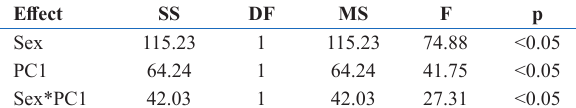
Table 1. Aegla marginata . ANCOVA of the scores for males and females individuals (sex), using the generalized body size (first axis of the principal component analysis, PC1) as a covariate. The scores were obtained using canonical discriminant analysis. SS: Sum of Squares; DF: Degrees of Freedom; MS: Mean Squares.